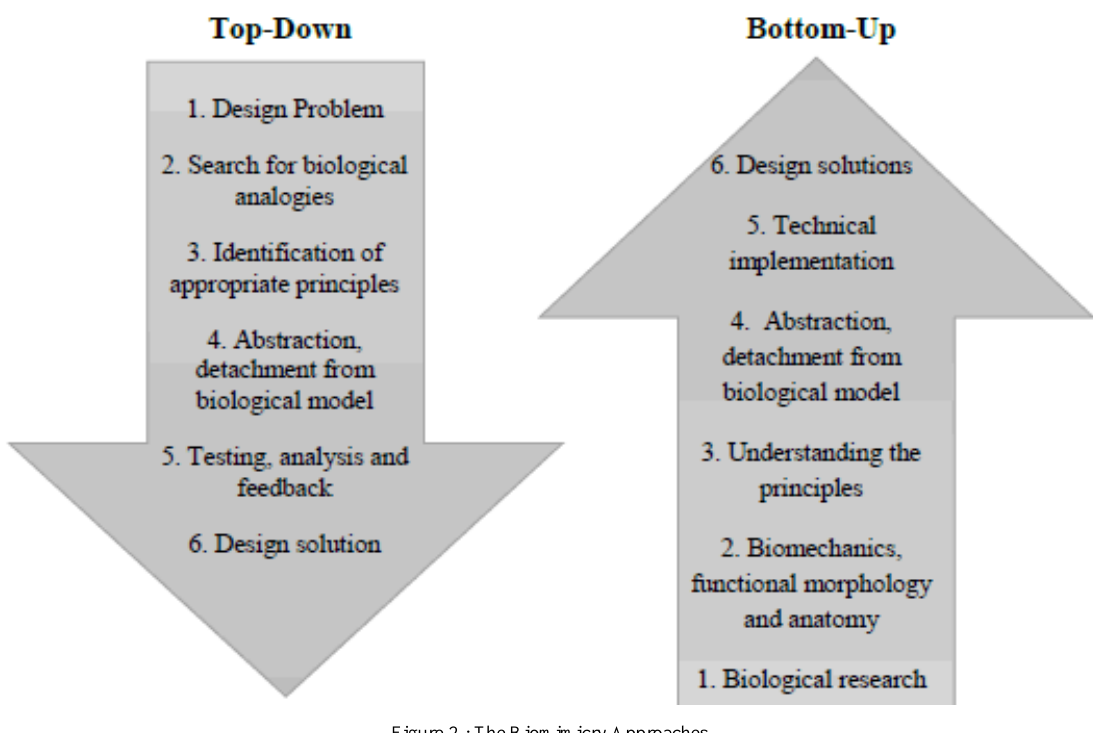
Figure 2 : The Biomimicry